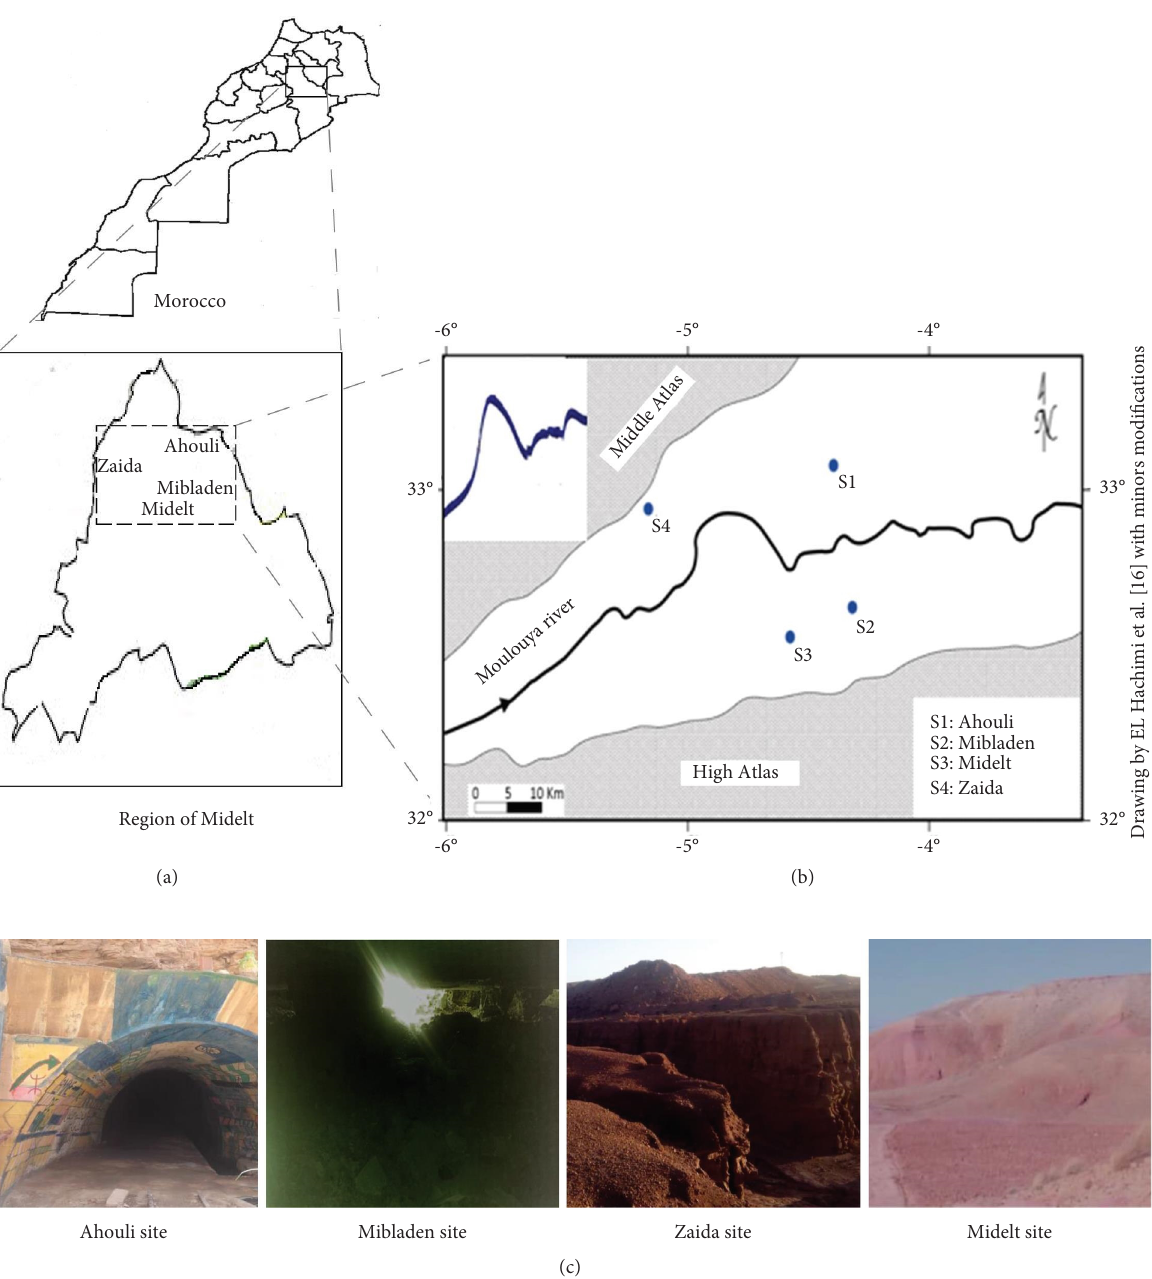
Figure 1: (a) Map of sampling sites of Actinobacteria isolation from the region of Midelt, between the Middle and High Atlas mountain ranges, in Morocco. (b) Positioning of the sampling sites of this study on the map drawn by El Hachimi et al. [16]. (c) Pictures of the sampling sites related to the present